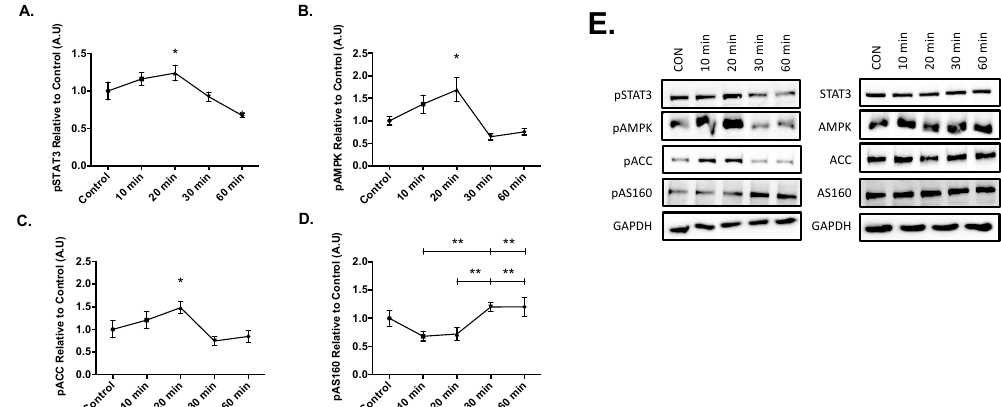
Figure 2. E ff ect of Acute IL-6 Treatment of SH-SY5Y Cells Over Time. SH-SY5Y cells were treated with 20 ng / mL of IL-6 for 10, 20, 30, and 60 min. ( A ) IL-6 treatment significantly increases phosphorylation of STAT3 (n = 3 per group). ( B ) IL-6 treatment significantly increases phosphorylation of AMPK (n = 3 per group). ( C ) IL-6 treatment significantly increases phosphorylation of ACC (n = 3 per group). ( D ) IL-6 treatment significantly increases phosphorylation of AS160 (n = 3 per group). ( E ) Representative blots are shown beside the quantified data. Data are presented as means ± SE. A.U., arbitrary units. * p ≤ 0.05, ** p ≤ 0.01, **** p ≤ 0.001, as determined using a one-way ANOVA followed by Fisher’s LSD post hoc analysis.